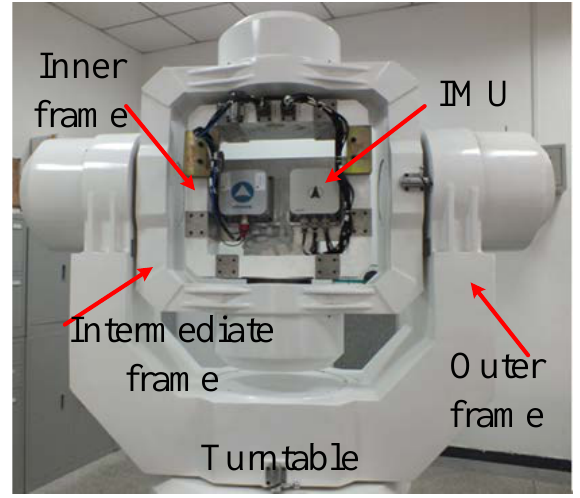
Figure 2. Experiment environment based on three-axis turntable .